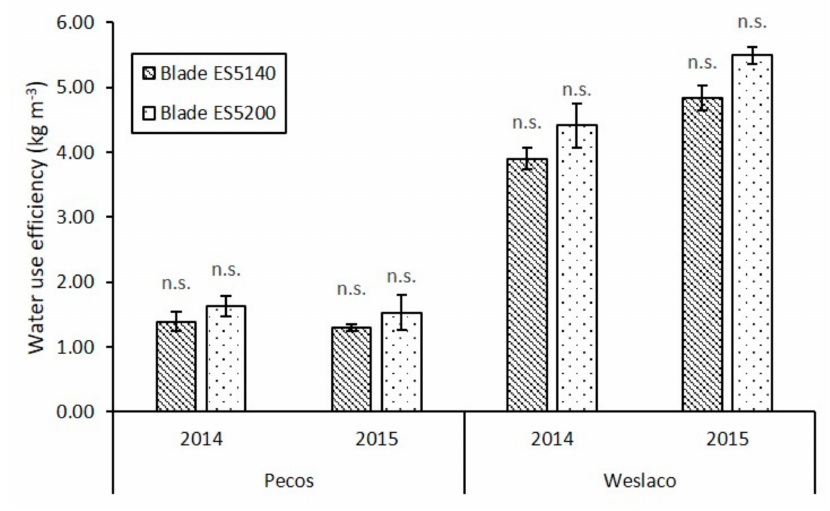
Figure 6. Water use e ffi ciency of the two energy sorghum cultivars at harvest